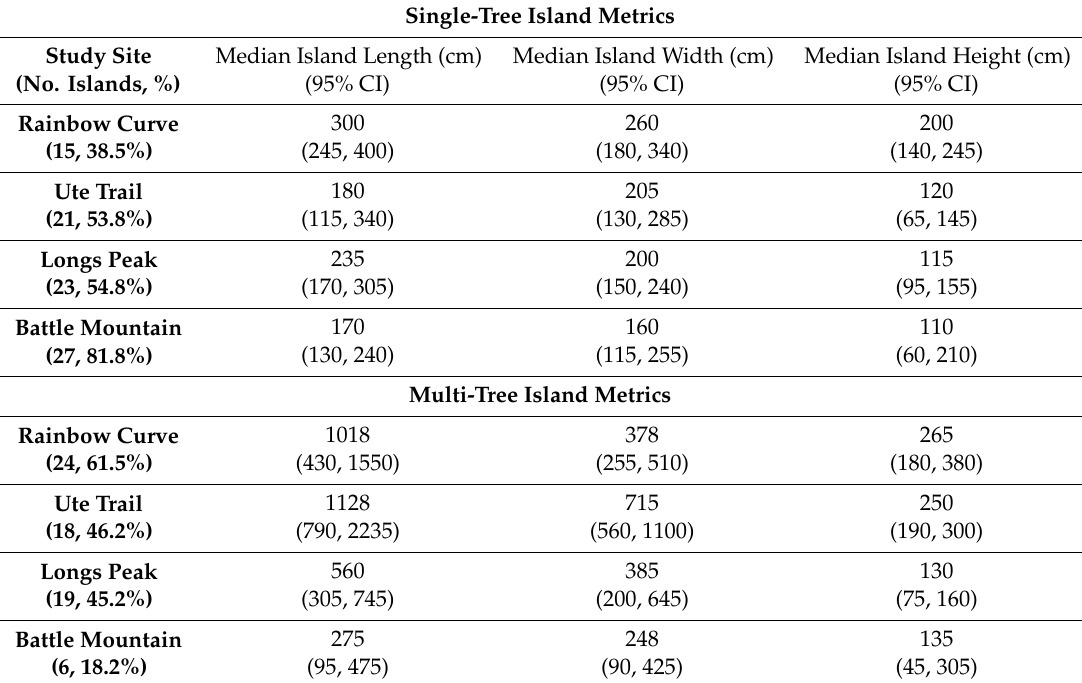
Table 2. Descriptive statistics for single- and multi-tree islands at each study